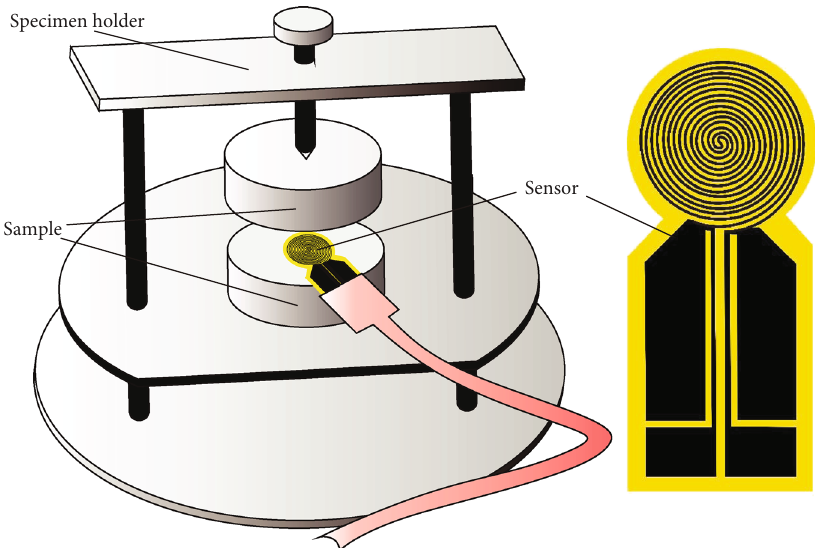
Figure 2: Sketch map of hot disk sensor and sample support.